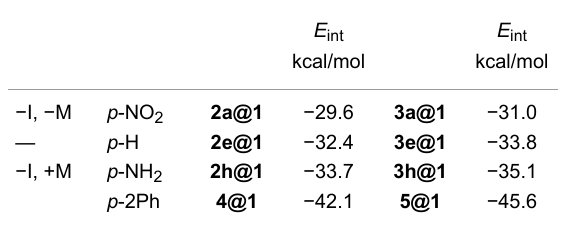
Table 4: Interaction energies E int for the different pseudorotaxane systems applying a solvent model, labeling see Figure 1. The first two columns list the substituents succeeded by their effects (mesomeric or inductive) as in Table